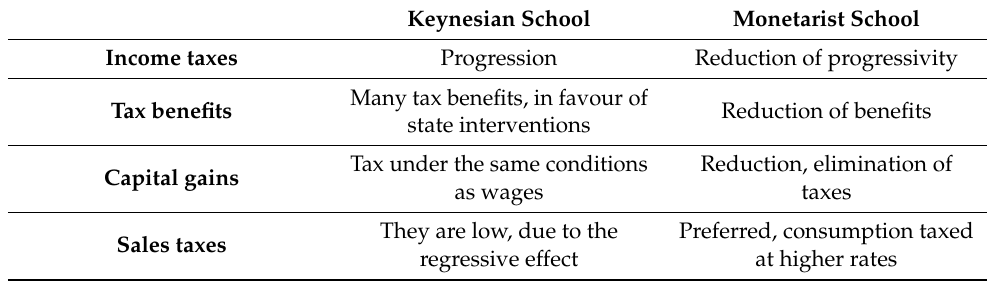
Table 1. The Keynesian and monetarist schools of economists’ views on taxation. Keynesian School Monetarist School Income taxes Progression Reduction of progressivity Many tax benefits, in favour of Tax benefits Reduction of benefits state interventions Tax under the same conditions Reduction, elimination of Capital gains as wages taxes They are low, due to the Preferred, consumption taxed Sales taxes regressive effect at higher